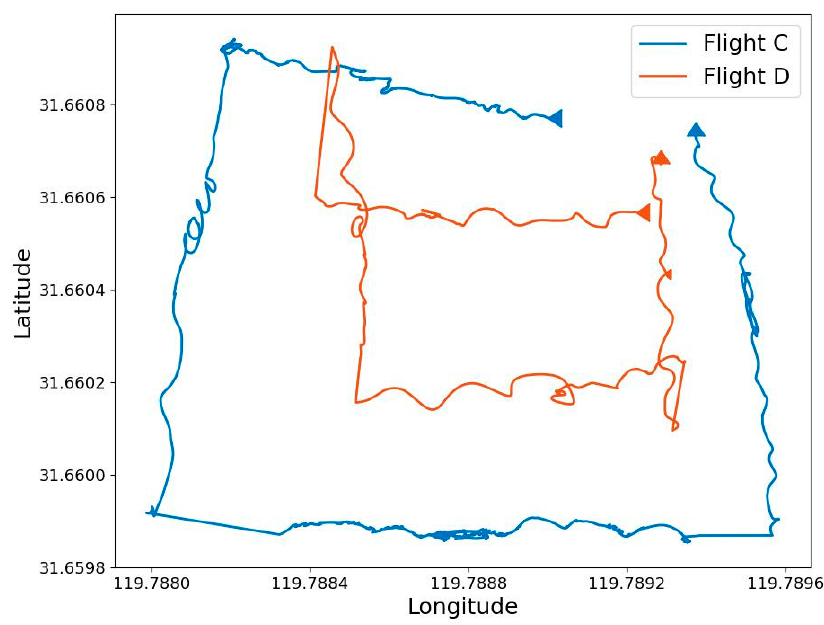
Figure 10. Flight C and Flight D flight paths. Table 2. Main technical parameters of GSMP-35U high-precision potassium optical pump magne-